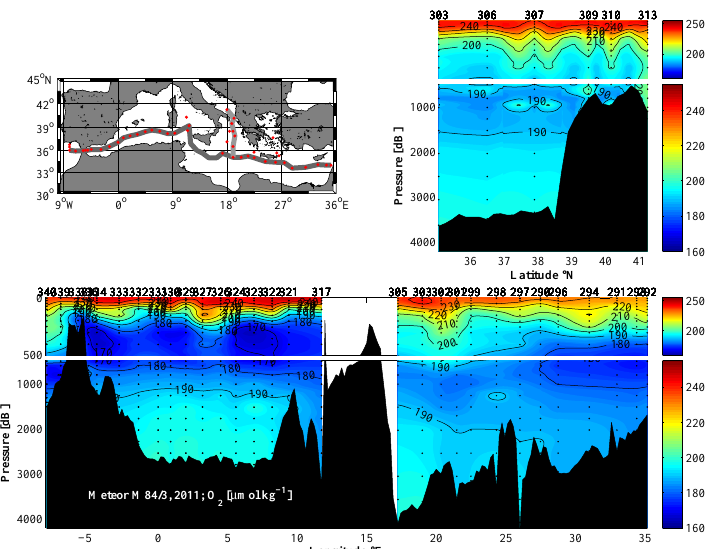
Fig. 6. Similar to Fig. 3, but for oxygen as determined from Winkler